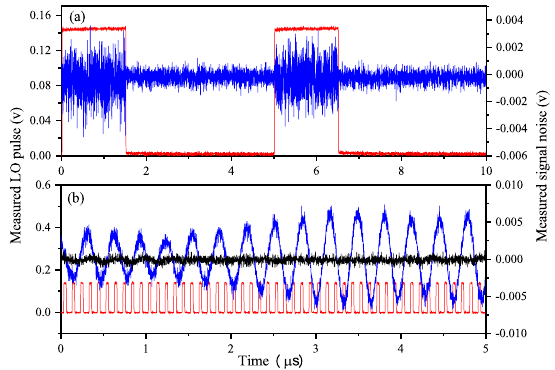
Figure 1. The schemes for measuring the noise of quantum state with pulsed local oscillator (LO) beam. ( a ) the pulse time is longer than the handling time. ( b ) The pulse time is shorter than the handling time. The red trace is the LO pulse sequence; the blue trace is the measured noise; and the black trace corresponds the electronic noise of